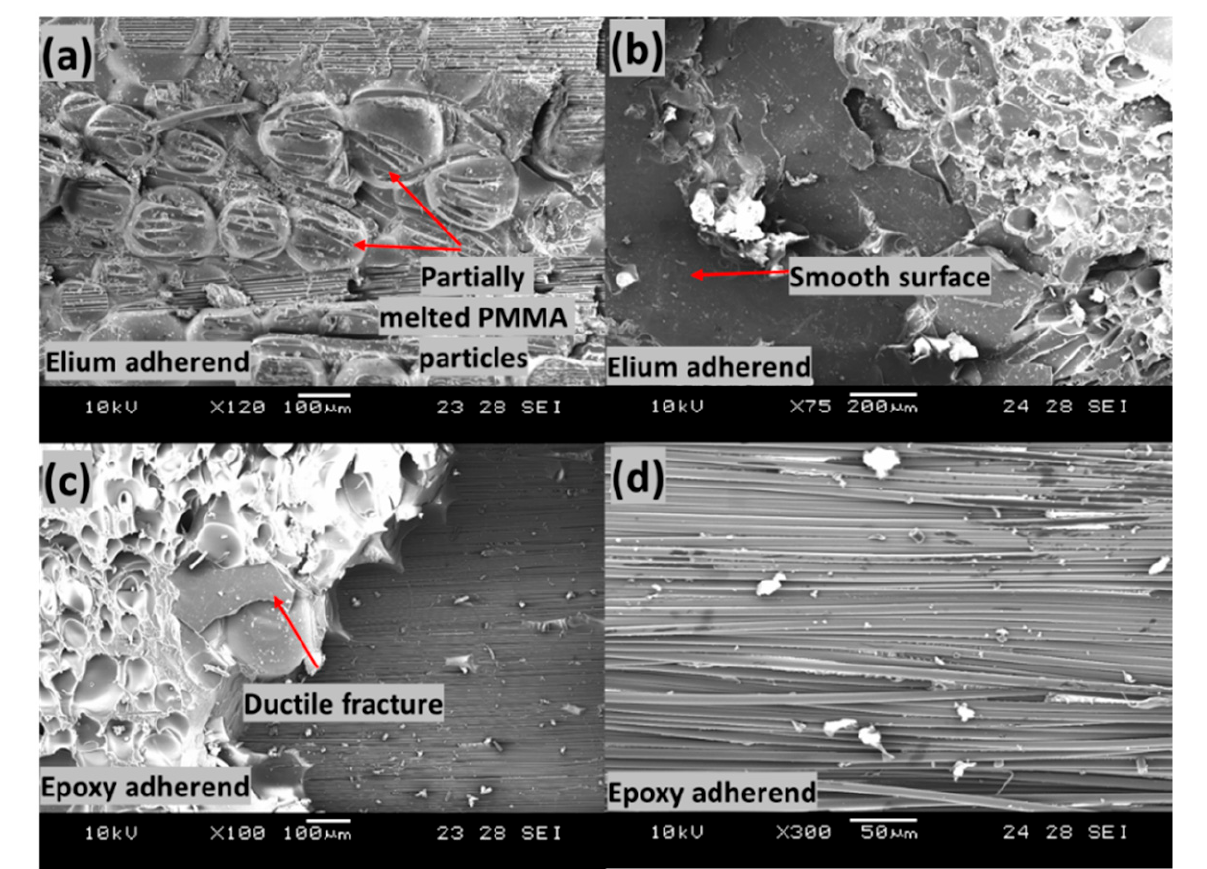
Figure 21. Scanning Electron Microscope fractography of EL-EP(Elium ® -Epoxy)_0.25_0.25 with minimum LSS. ( a , b ) Elium adherend and ( c , d ) epoxy adherend.